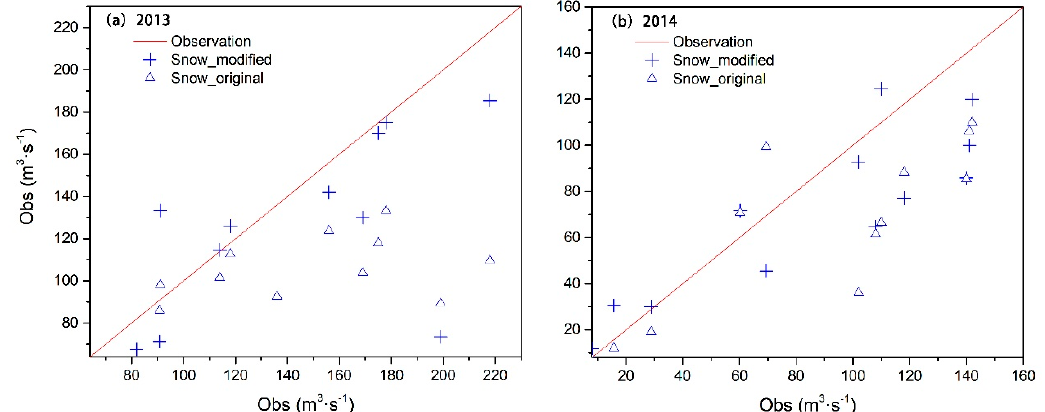
Figure 8. All of the flood peaks simulated by the model compared with the observations: ( a ) Comparison between simulated flood peak values and observations before and after model modification during the calibration period; ( b ) comparison between simulated flood peak values and observations before and after model modification during the validation period.